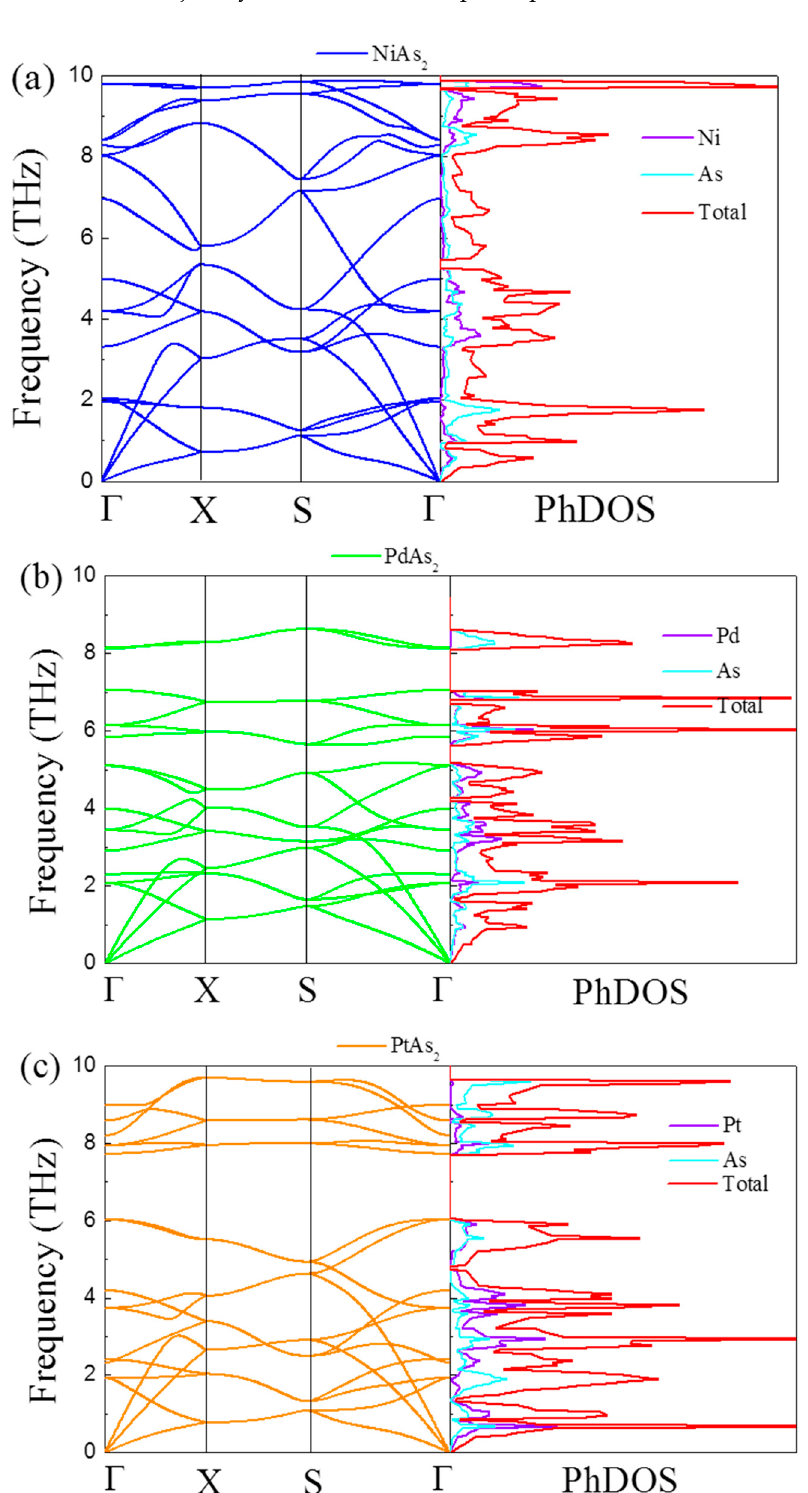
Figure 4. Phonon dispersion and corresponding phonon density of states (PhDOS) of monolayer ( a ) NiAs 2 , ( b ) PdAs 2 and ( c ) PtAs 2 along several high symmetry directions.